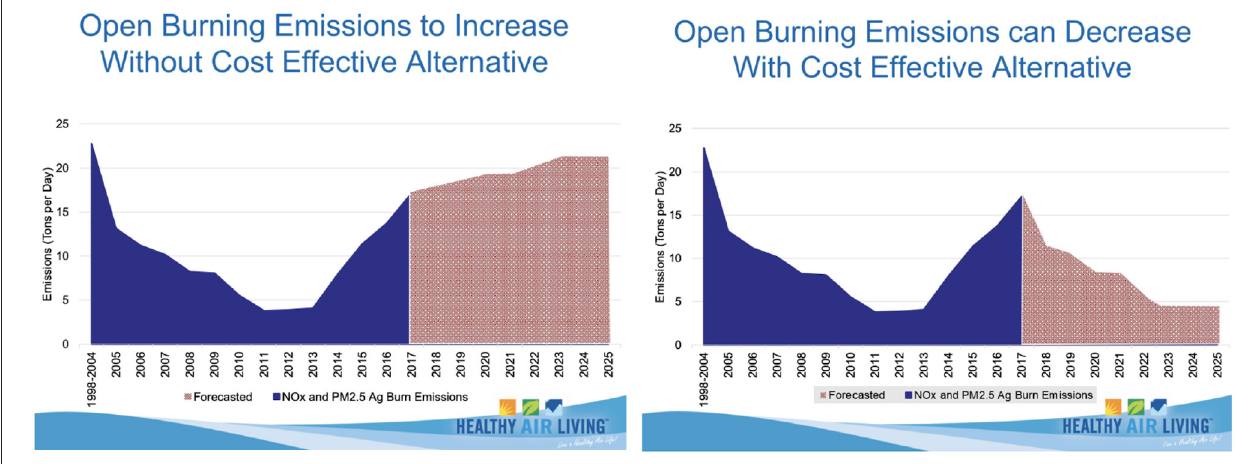
FIGURE 2 | Expected emissions of key health-impacting air pollutants from agricultural burning in the San Joaquin Valley. Reproduced from Olsen